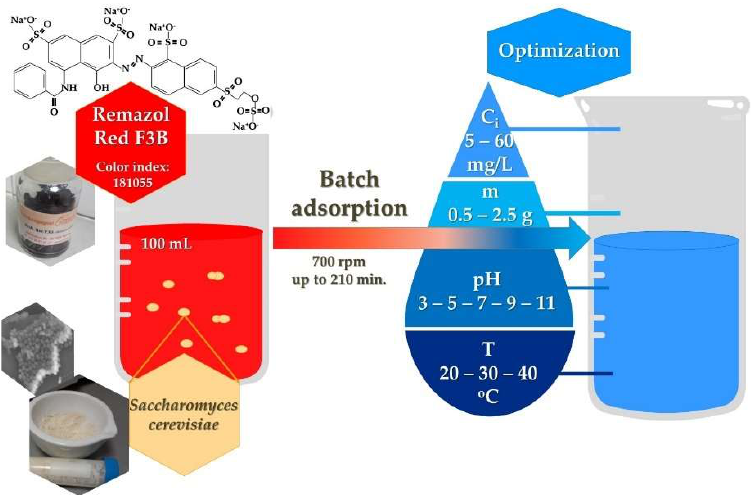
Figure 7. Graphical representation of the adsorption experiment with optimization initial parame- ters .